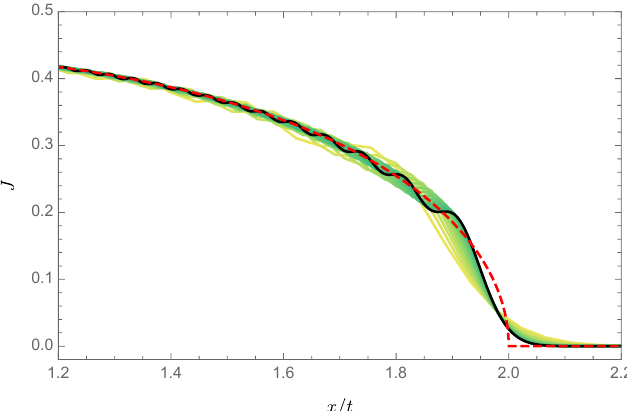
Figure 7: Current profile J as a function of x / t close to the right front x / t = 2 for j = 0.4. Full lines: numerical data for different times t = 25 to 95 (yellow to green) at steps equal to 5 and t = 100 (black line), dashed red line: analytical asymptotic expression at t → ∞ from